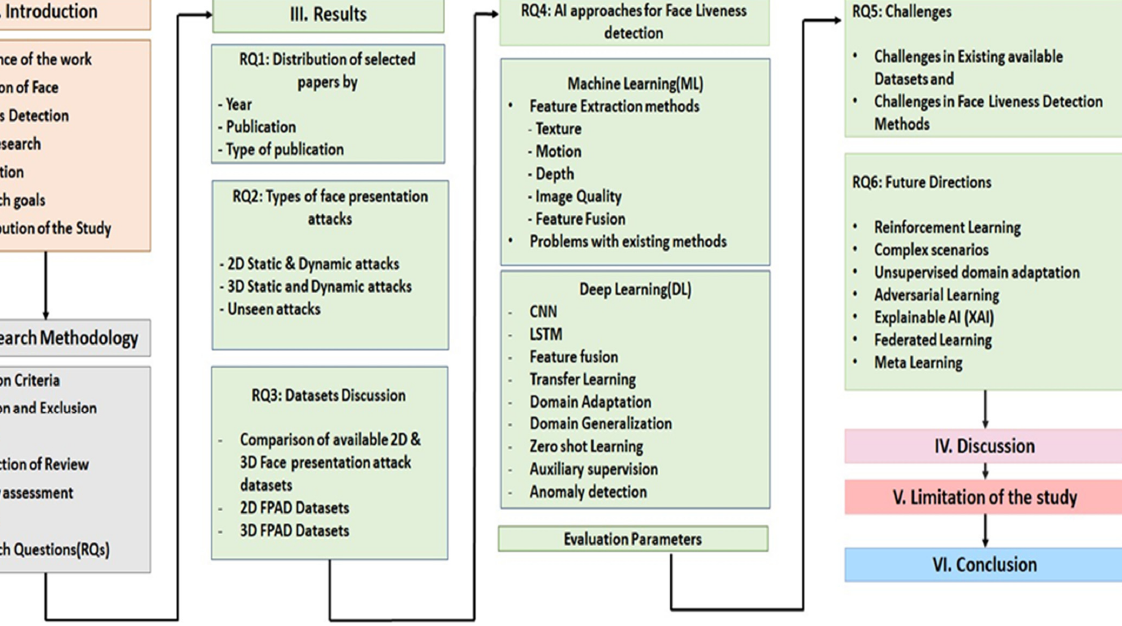
Figure 2. Outline of SLR.